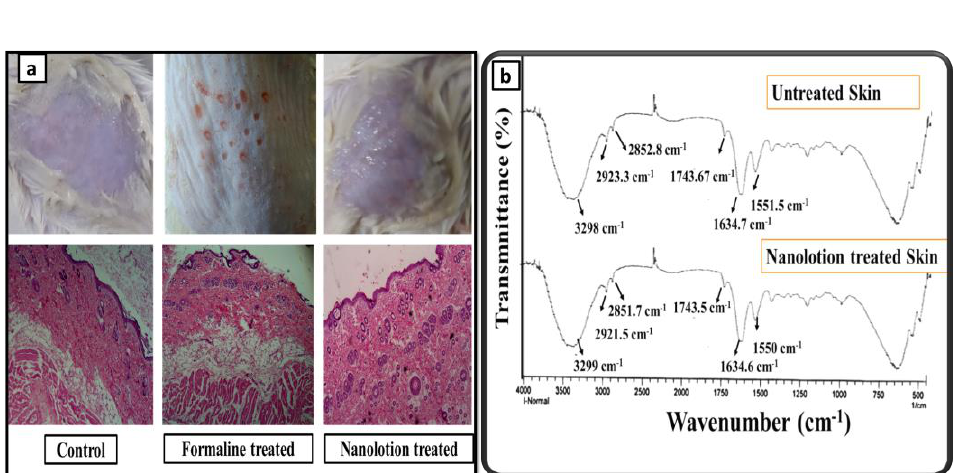
Figure 5. Biocompatibility studies of SSD nanolotion. ( a ) Skin irritation and histological analysis under microscope; ( b ) FTIR spectra of SSD nanolotion and formalin-treated skin. Table 4. Comparative primary irritancy index (PII) of SSD-loaded nanolotion.